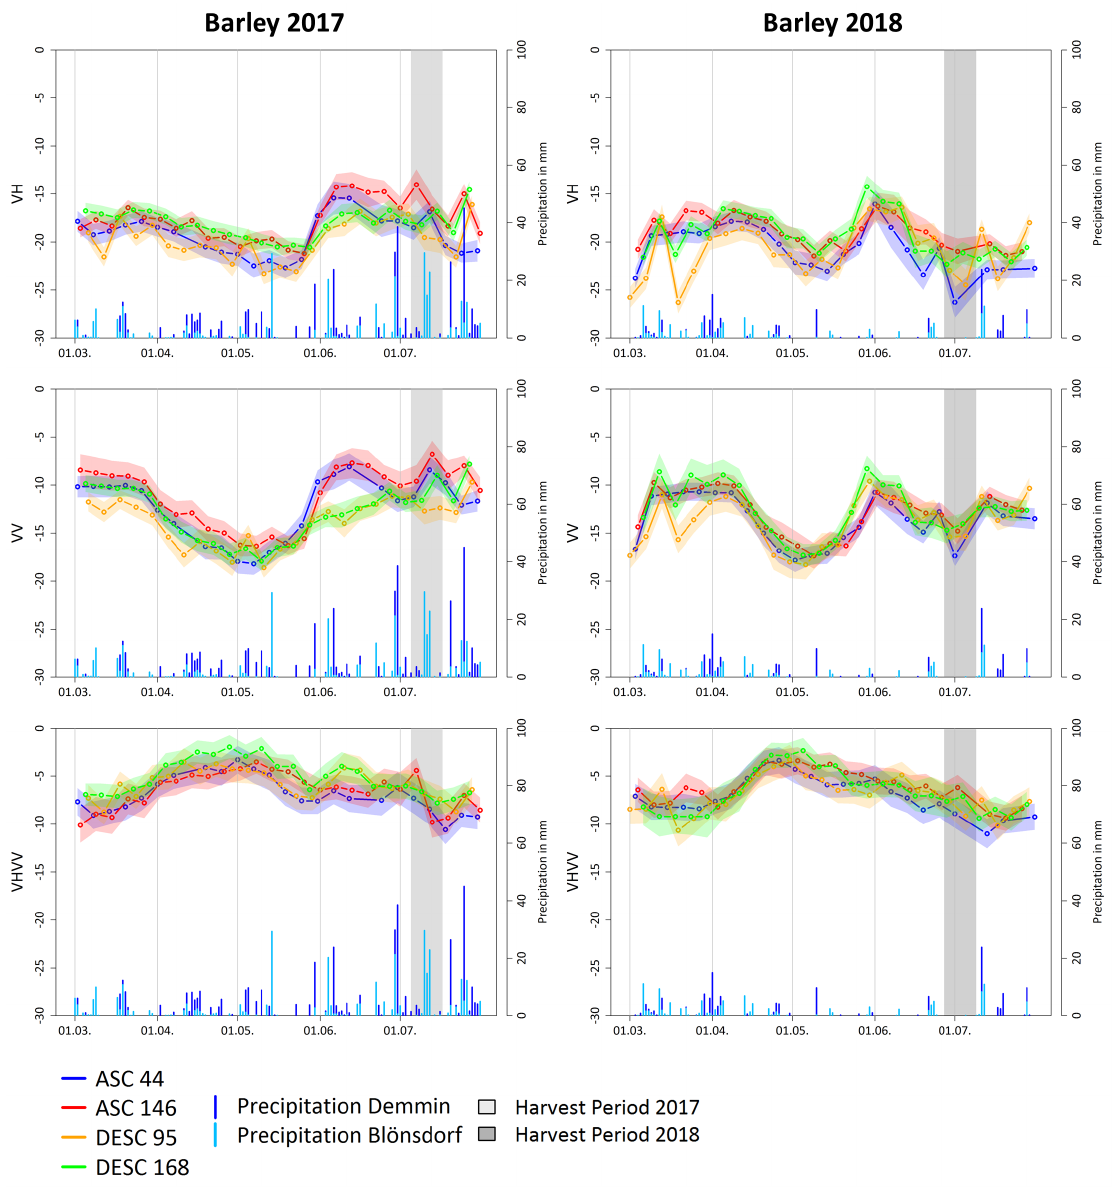
Figure 6. Temporal profiles of backscatter parameters VV, VH and VH/VV of barley fields in 2017 ( left ) and 2018 ( right ). Standard deviations are depicted as polygons around lines. Blue bars represent daily precipitation sums for the test sites Demmin (dark blue) and Blönsdorf (light